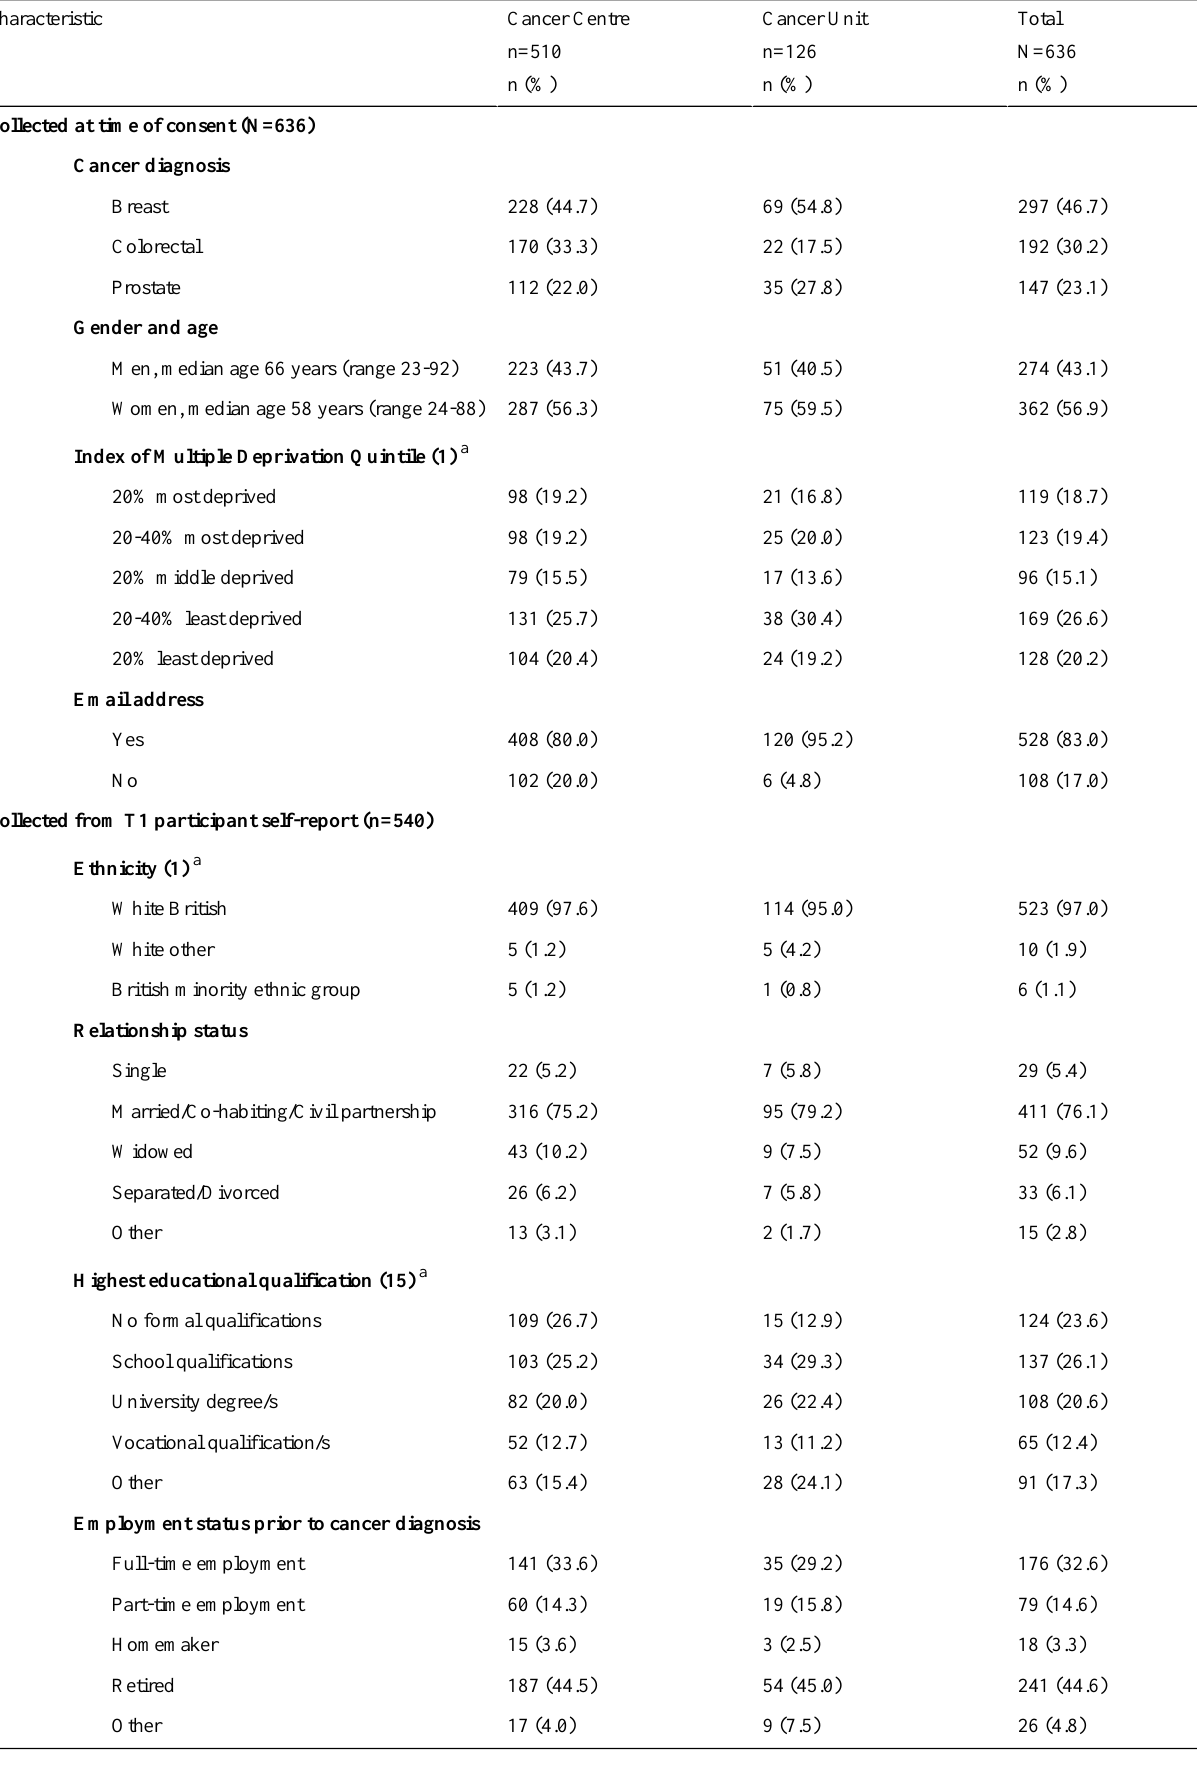
Table 1. Clinical and sociodemographic characteristics of